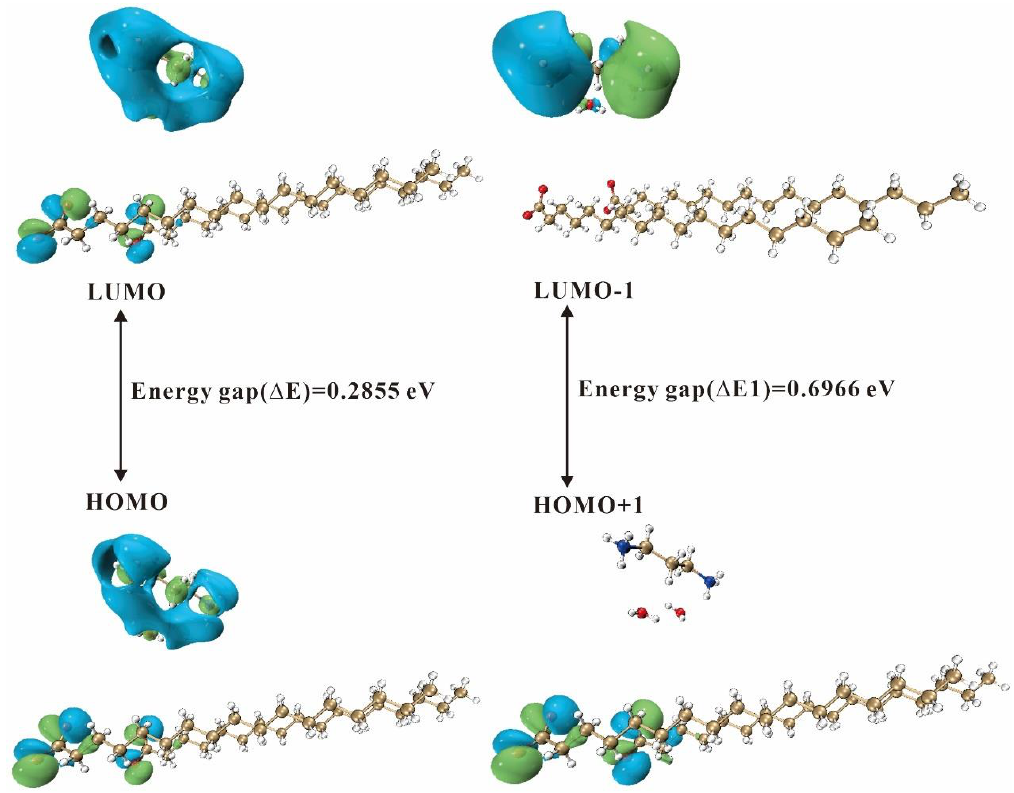
Figure 12. Energy level diagram of the 3C17 molecule.